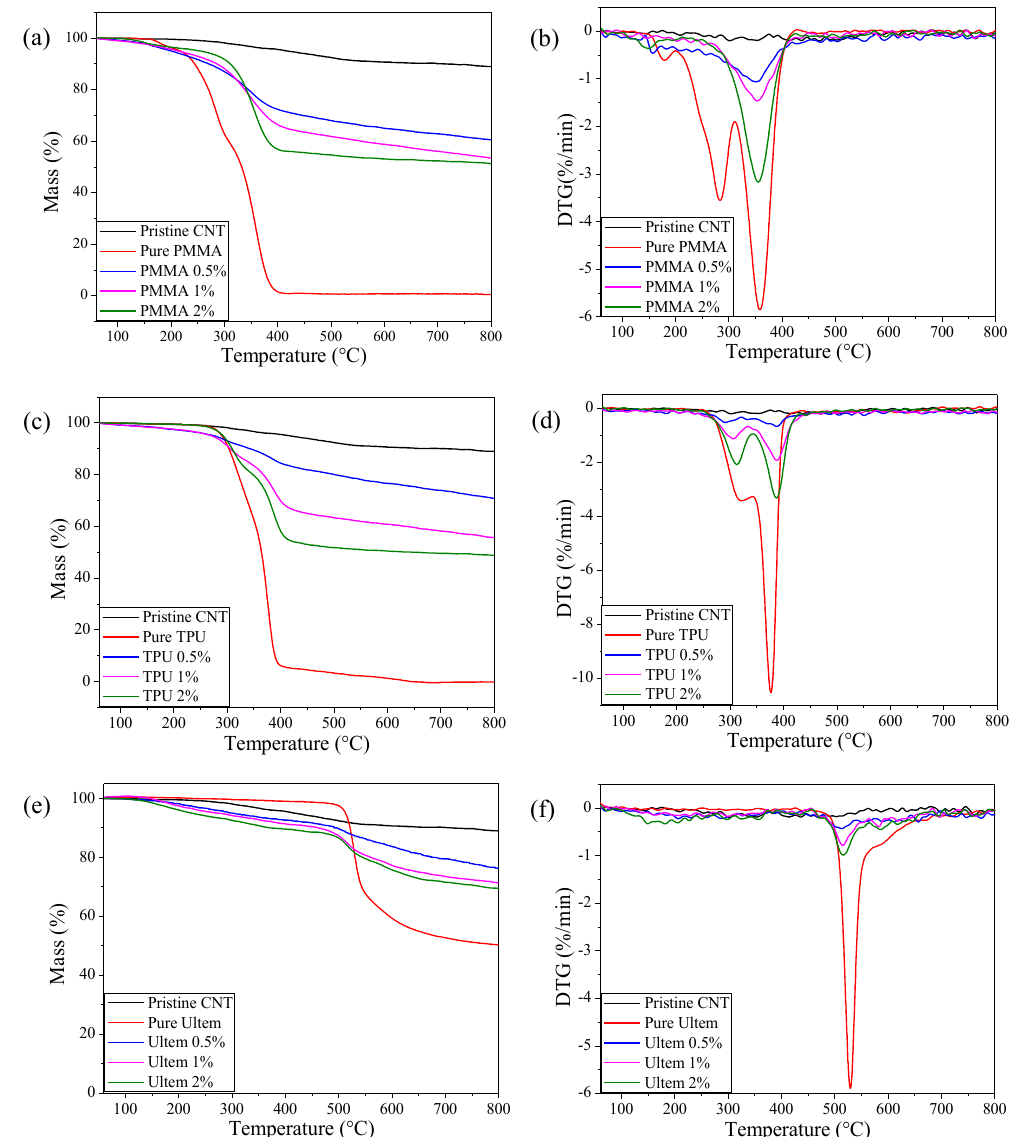
Figure 3. Graphs showing thermogravimetric analysis (TGA) and di ff erential thermogravimetric (DTG) plots for ( a , b ) poly (methyl methacrylate) (PMMA)-CNT, ( c , d ) thermoplastic polyurethane (TPU)-CNT and ( e , f ) Ultem TM -CNT composites at di ff erent concentrations. Experiments were performed in a nitrogen environment with an alumina crucible at a heating rate of 5 ◦ C /